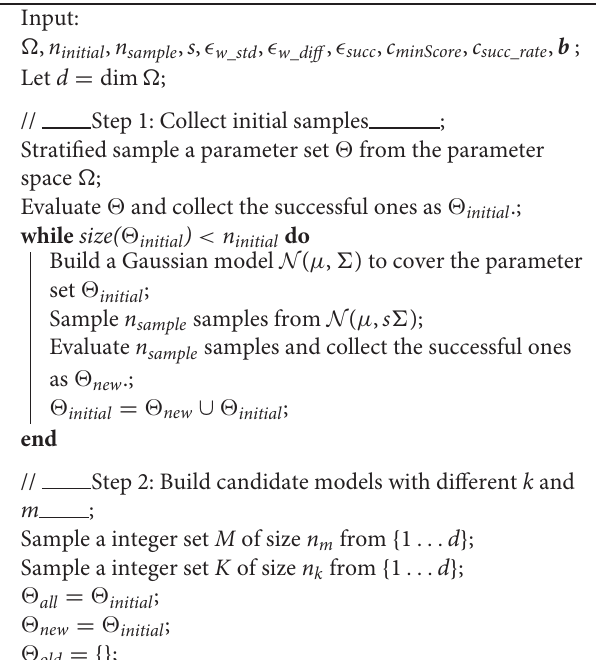
Algorithm 1: GMM Model Construction Pipeline Algorithm 2: BuildModelOnPCA( 2 old , 2 new , k , m , c minScore , b